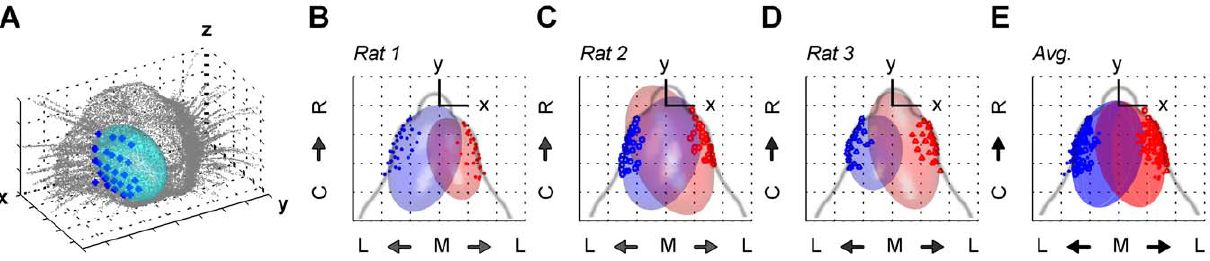
Figure 2. Ellipsoidal fits to the mystacial pad. ( A ) An example from one rat of the best-fit ellipsoid to whisker base-points on the right side of the mystacial pad. Whisker base-points are shown in blue and the best-fit ellipsoid in cyan. The rat head is placed in the standard position and orientation, and the view for this figure was chosen so as to best illustrate the mystacial pad. ( B–D ) Aerial view of the mystacial pad ellipsoid fits for each of the three rats scanned in 3D. Note the close fits to the contours of the rat’s cheek (gray curve). ( E ) Model ellipsoid obtained from ellipsoids averaged across all rats. All base-points from all rats scanned in 3D are shown. For all plots B–E, left array base-points and best-fit ellipsoids are in blue; right array base-points and best-fit ellipsoids are in red; and grid lines represent 5 mm increments on all axes.